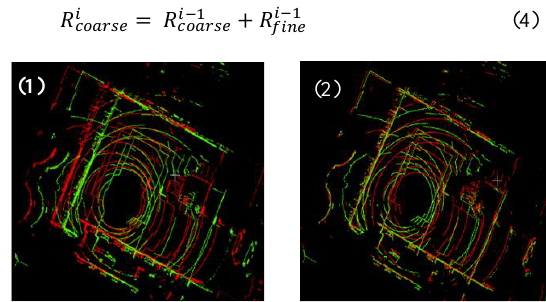
Figure 4. Situation of two sequential scans before (1) and after (2) coarse registration.